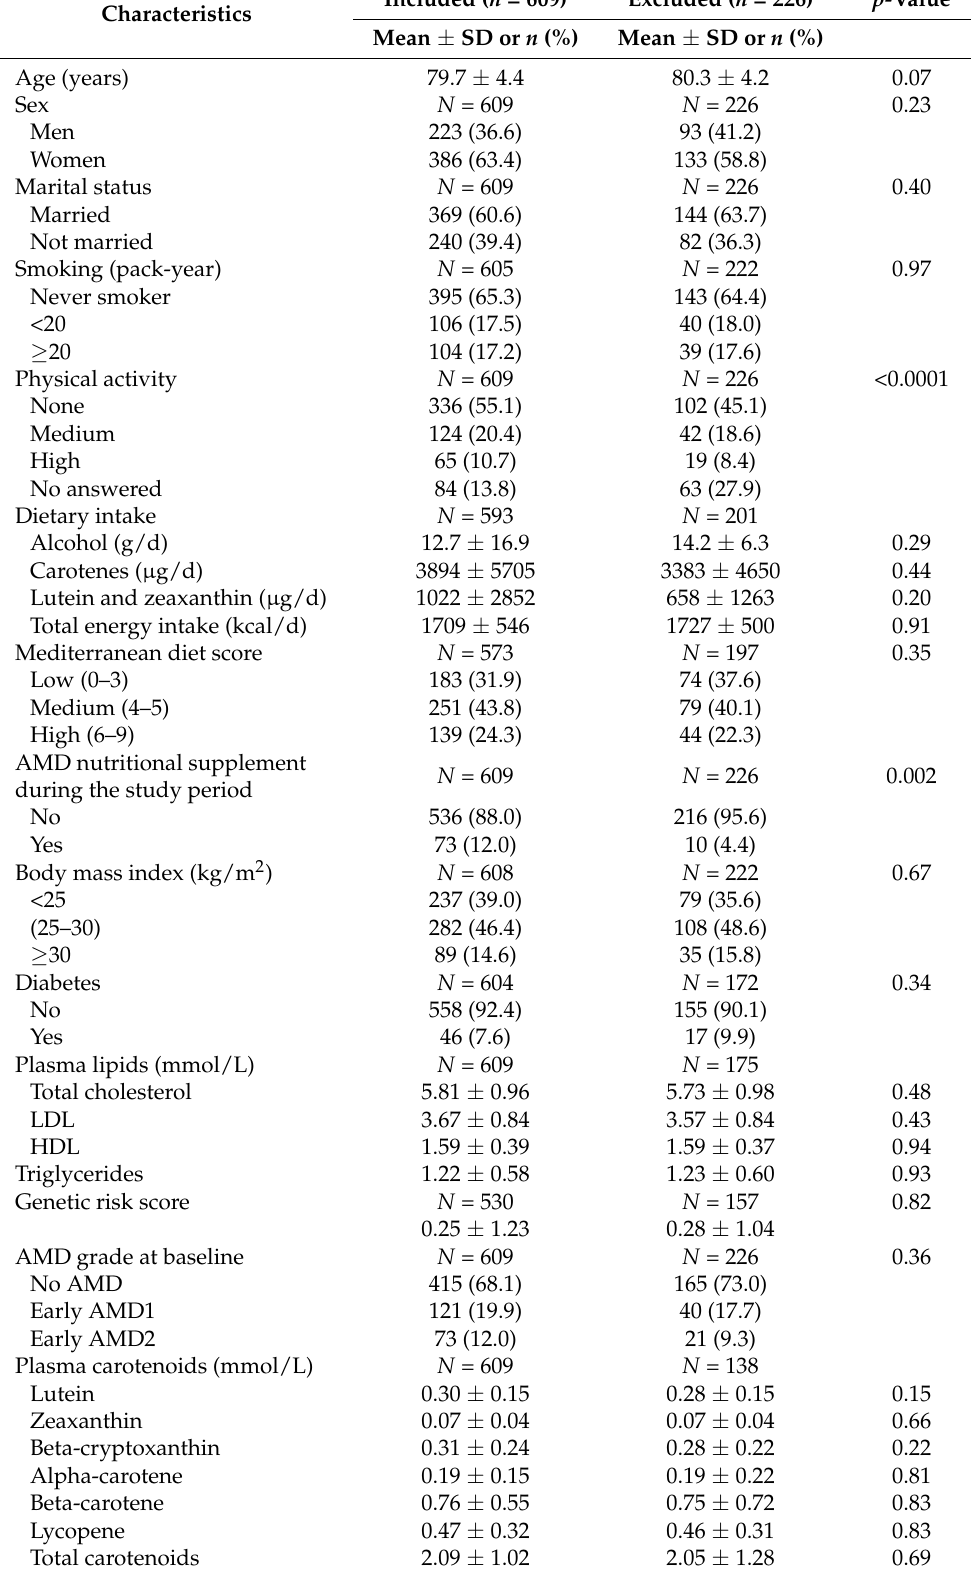
Table 1. Baseline sociodemographic, lifestyle, medical, ocular and genetic characteristics according to participants included and excluded from analyses. Alienor study,